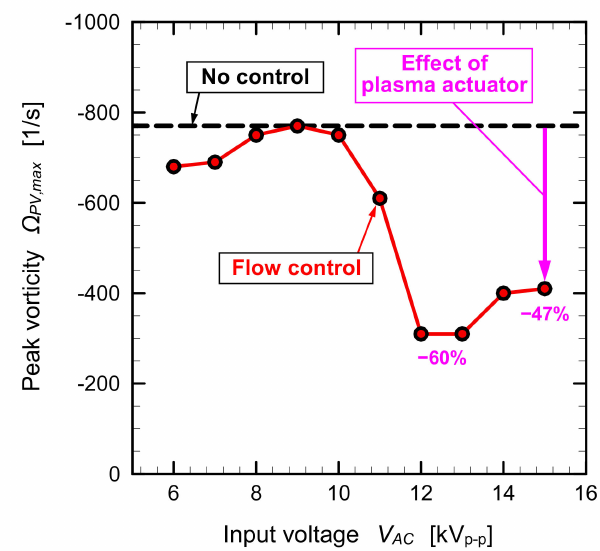
Figure 20. Peak vorticity of passage vortex in center passage ( U FS , out = 4.7 m /